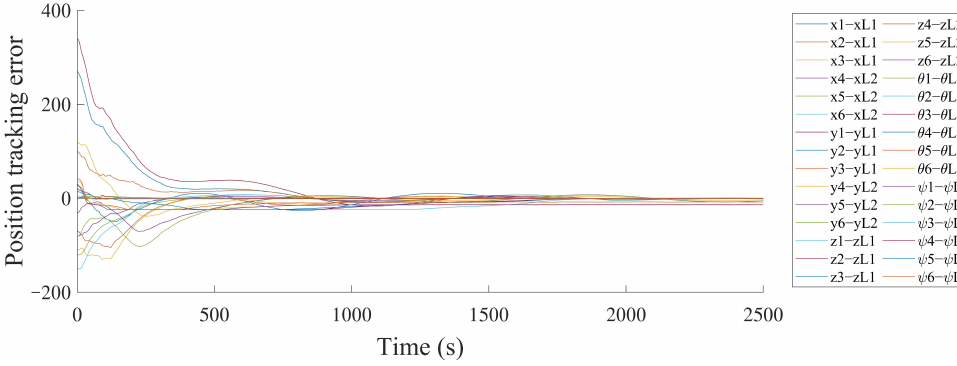
Figure 12. Position trajectories of a multiple stochastic AUV system in a contrastsimulation.